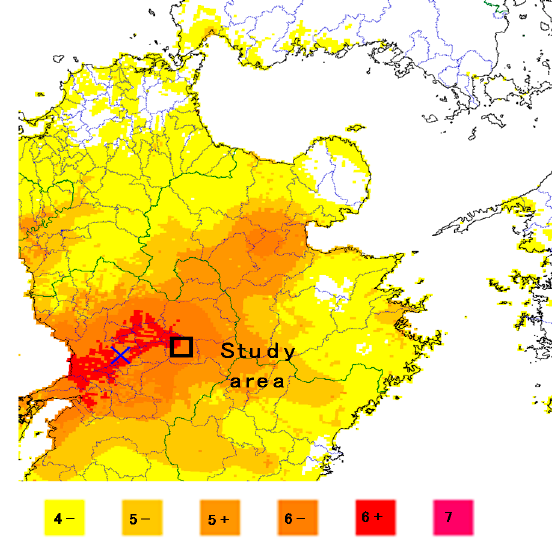
Figure 2. The intensity distribution of the Kumamoto earthquake (1:25 on 16th April 2016) in Japan’s Metrological Agency (JMA) seismic intensity scale. [36].